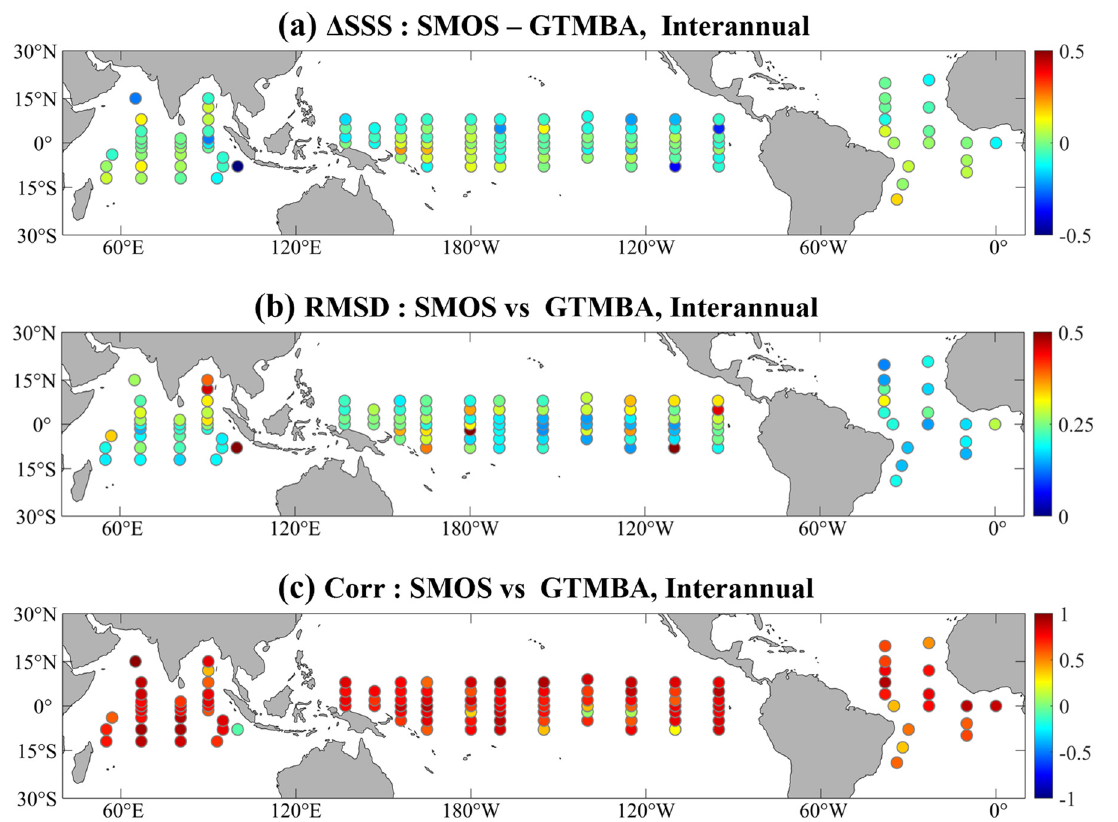
Figure 13. Comparison of SMOS SSS with salinity measured by GTMBA buoys at 1 m depth at interannual scale in terms of ( a ) Δ SSS, ( b ) STD and ( c ) correlation coefficient. The time range was from January 2011 to December 2019.